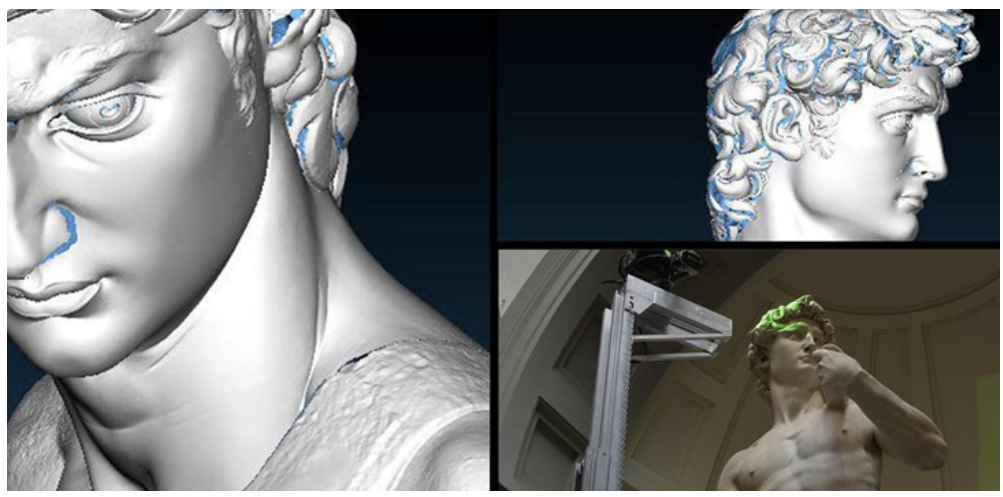
Fig. 3 M. Lo Turco, The